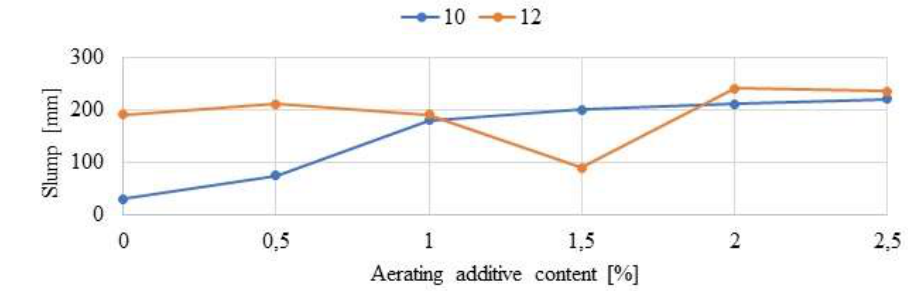
Figure 4. Series no. 10, 12 - Dependence of the amount of aerating additive on slump.